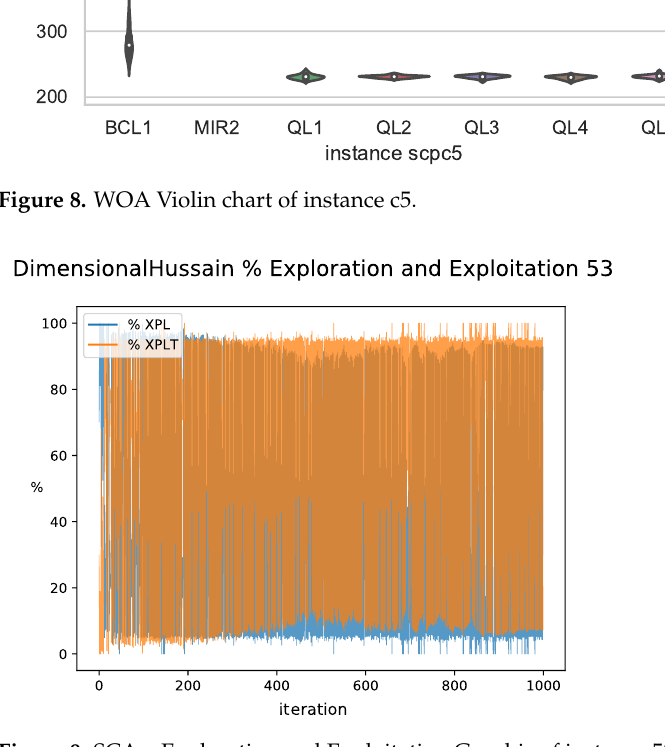
Figure 9. SCA—Exploration and Exploitation Graphic of instance 53 version QL5.